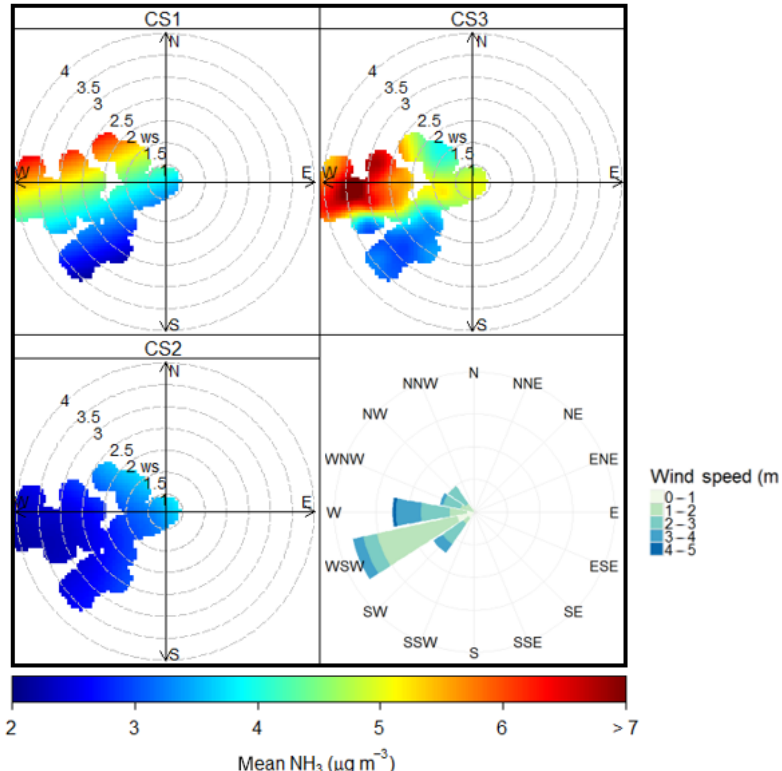
Figure 3. Polar plots showing averaged NH 3 concentrations (colour axis) as a function of wind speed (radial axis) and wind direction (cardi- nal direction) for each miniDOAS system, and a wind rose showing the prevailing wind direction, Period 1 (18–20 May). The concentration polar plots were produced using the openair R package (Carslaw et al.,